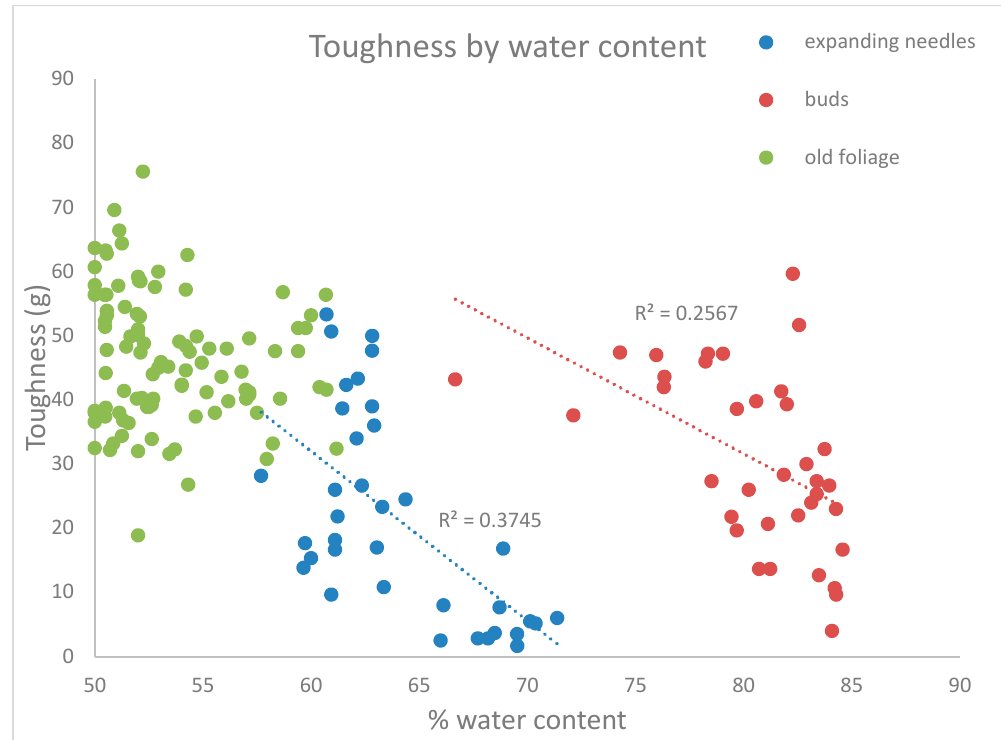
Figure 2. Regressions of toughness against water content. Regression lines and R 2 values are shown for expanding foliage and for buds, but not for mature foliage because the relationship was not statistically significant.